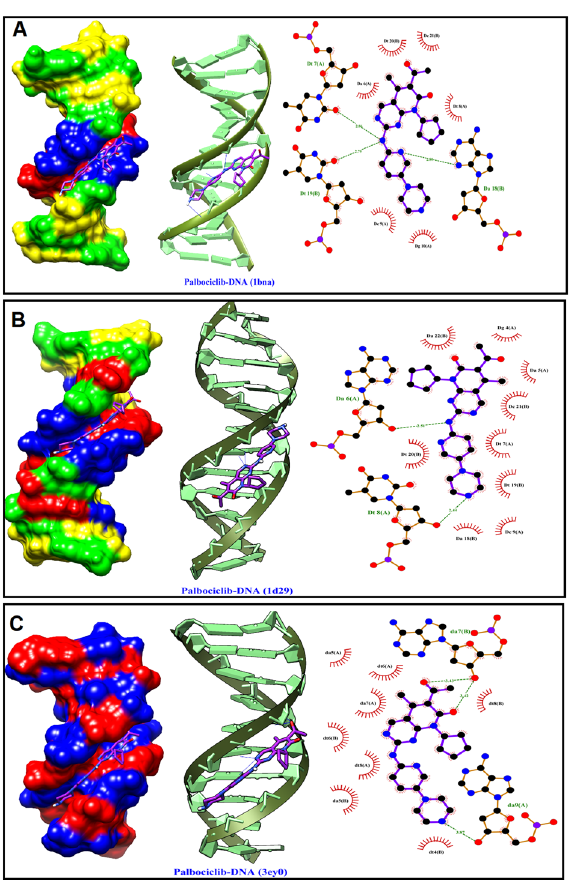
Figure 9. The lowest binding free energy pose for PLB on the three B-DNA fragments: Surface view (left) and 2D schematic view (right); deoxy cytosine (DC) is green, deoxy adenine (DA) is red, deoxy guanine (DG) is yellow, deoxy thymine (DT) is blue, cartoon presentation (right), H-bond interactions (green-dashed lines), hydrogen bond length (Å), and the hydrophobic interactions